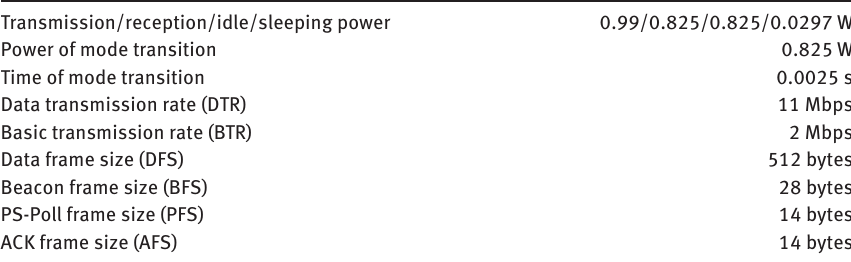
Table 2. The Simulation Parameters in